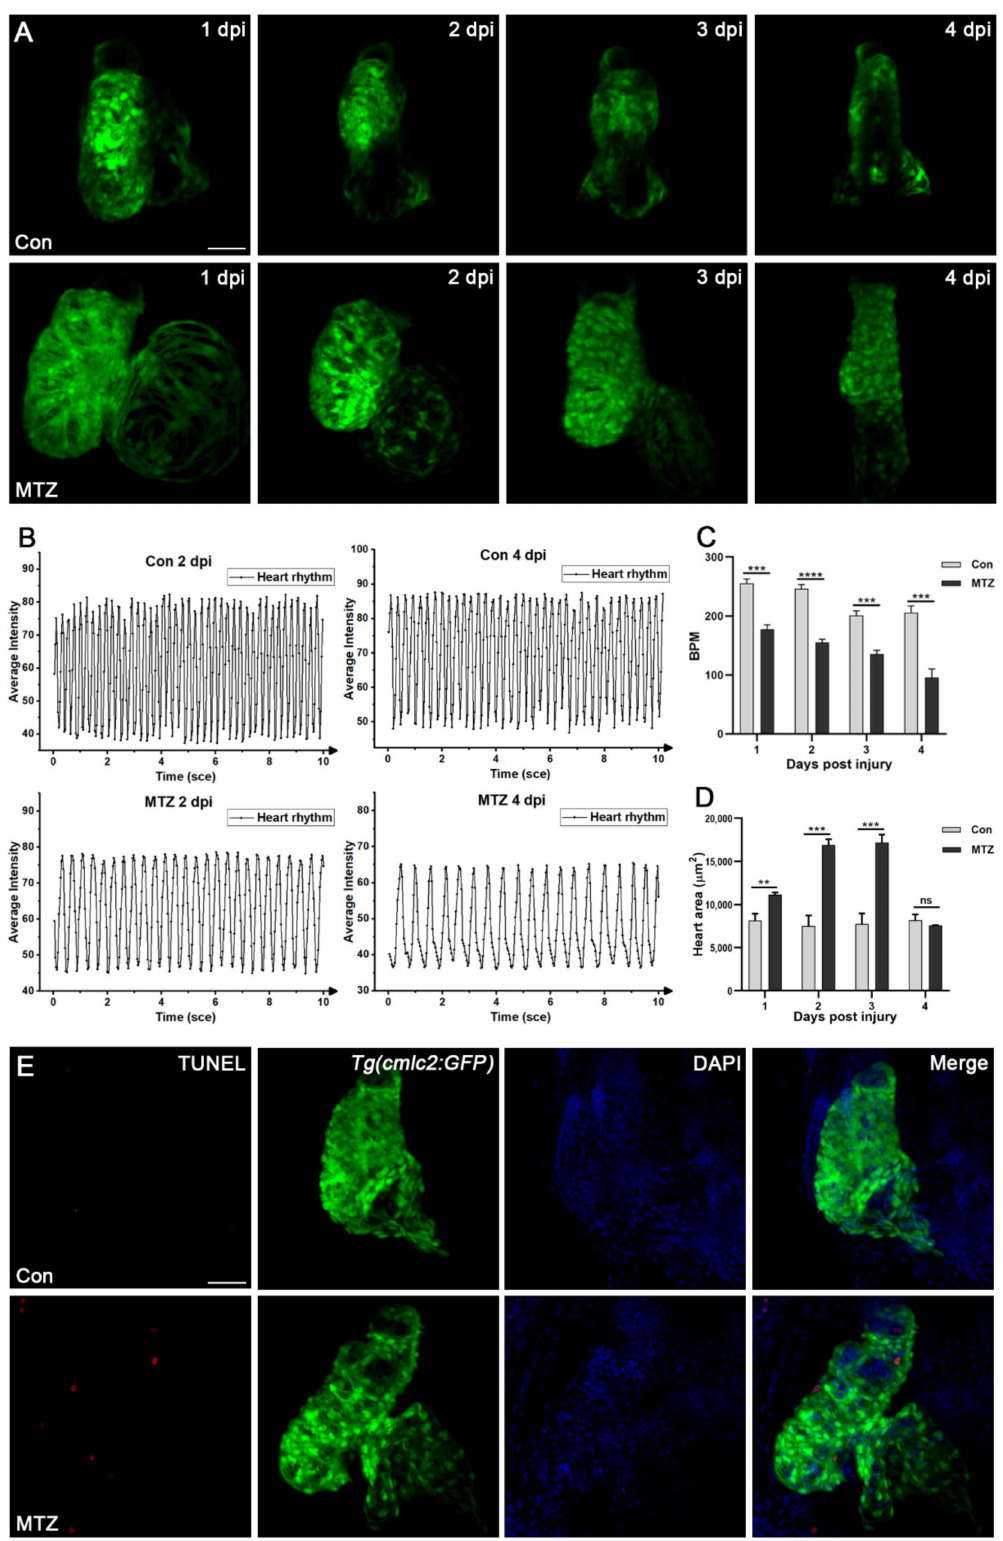
Figure 4. ARF induced heart failure in zebrafish larvae. The heart rate ( A – C ) and heart size ( D ) of Tg(cdh17:Dendra2- NTR;cmlc2:GFP) zebrafish larvae treated with MTZ or control were detected ( n = 5). ( E ) TUNEL-positive apoptotic cardiomyocytes (red) were detected in the heart of Tg(cdh17:Dendra2-NTR;cmlc2:GFP) zebrafish larvae treated with MTZ, but not in the control ( n = 30). Scare bar: 100 µ m. Mean ± SEM; ns, not significant; ** p < 0.01, *** p < 0.001, **** p < 0.0001, ANOVA/Dunnett’s test compared with